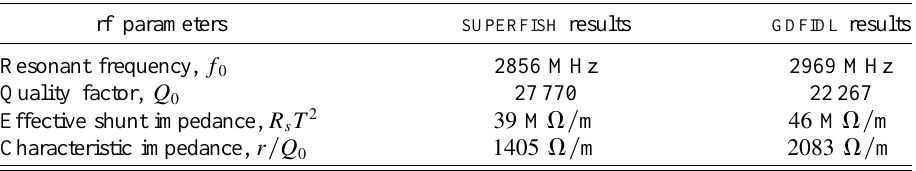
TABLE I. Comparison of various rf parameters of the prototype PWT1 linac obtained from SUPERFISH and GDFIDL